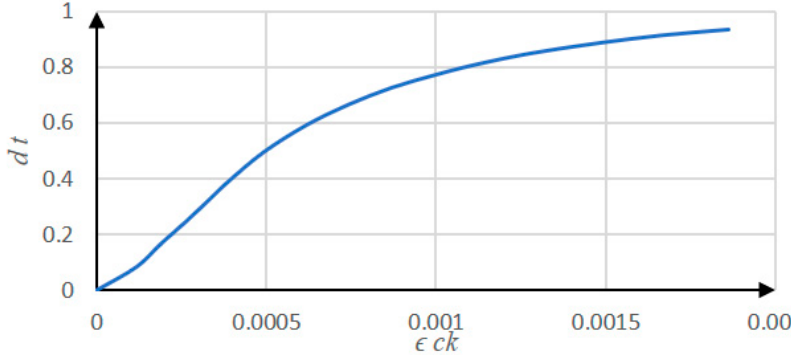
Figure 13. Damage of concrete in compression.